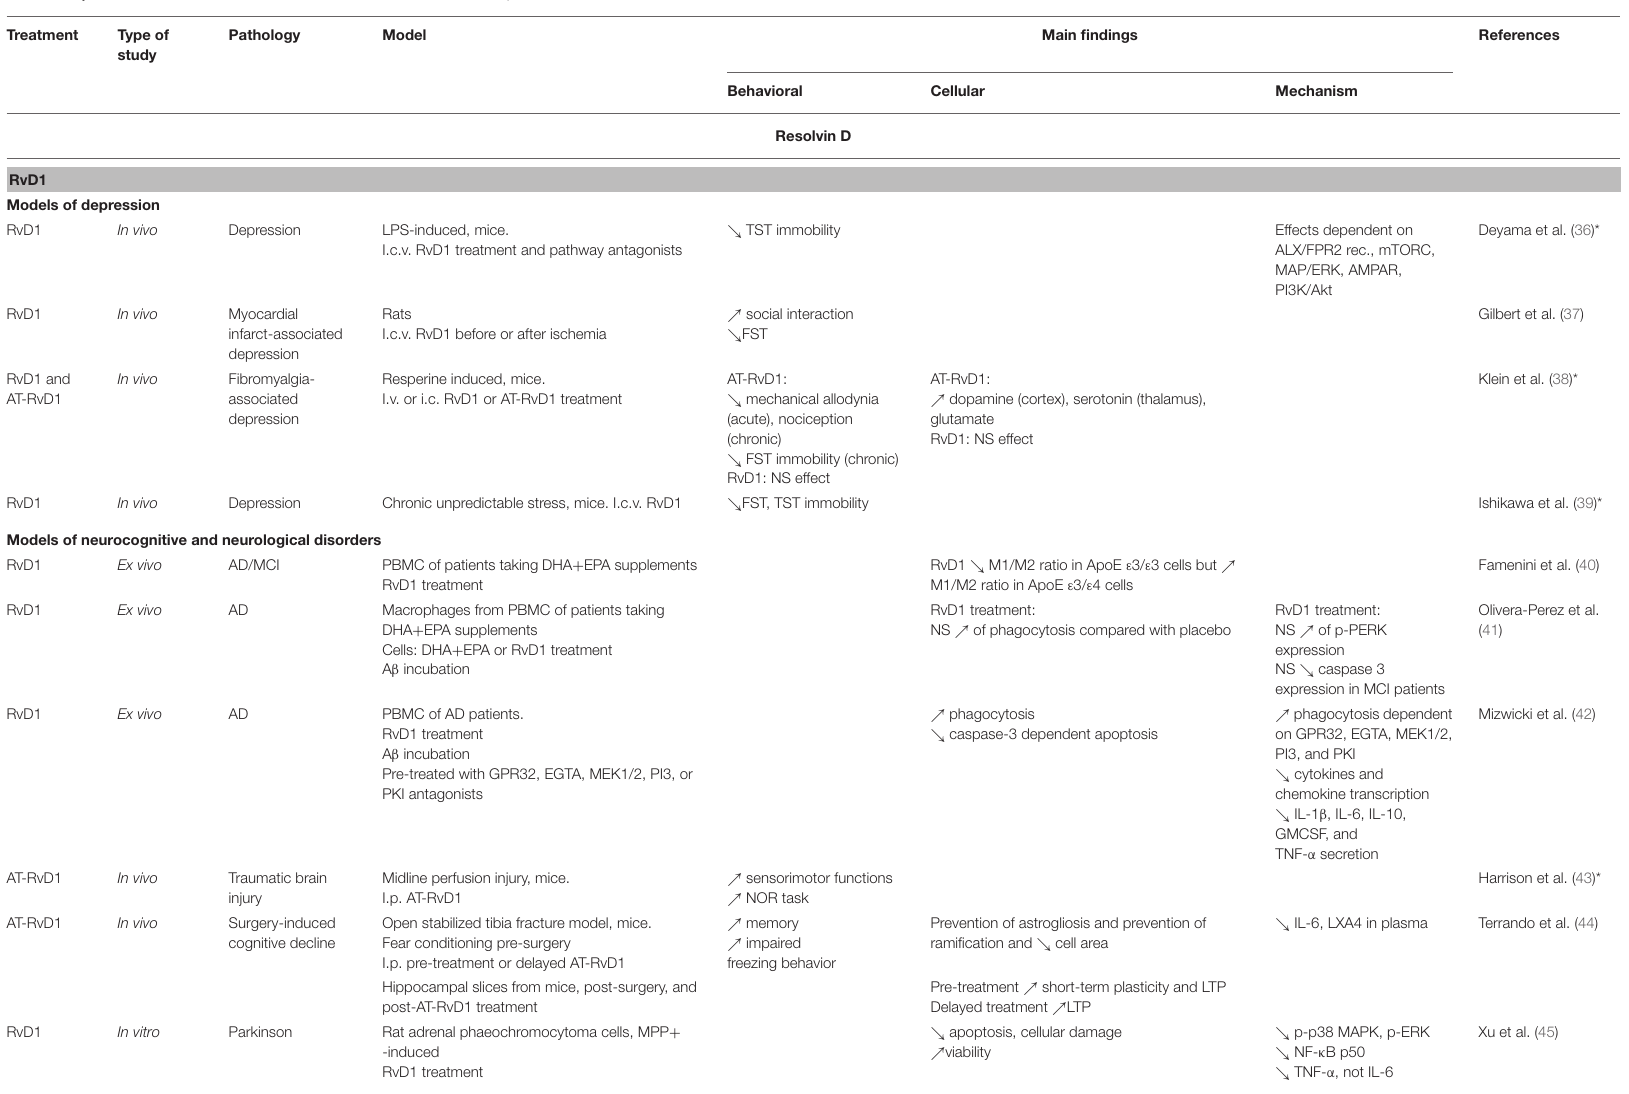
TABLE 1 | Behavioral, cellular and molecular outcomes identified upon treatment with SPMs.